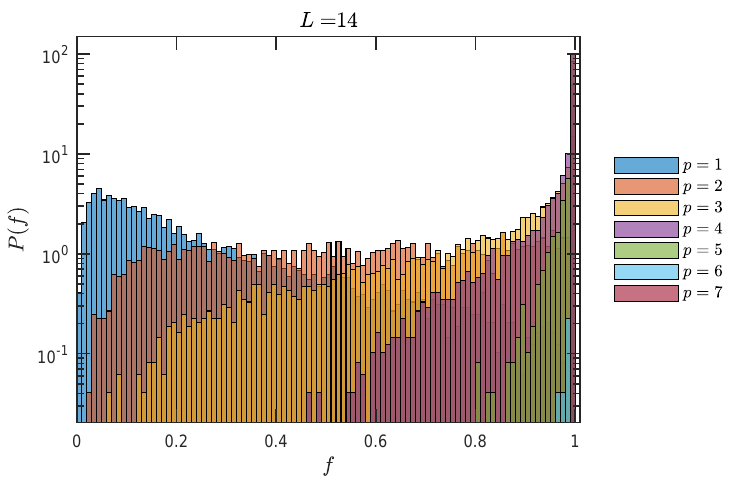
Figure 8: Probability distribution of optimal fidelities, for system size L = 14. For p = L / 2, the optimal fidelities are singularly peaked at f = 1, indicating that all in- stances of random states produced by VQCS perfectly; this is in contrast to p < L / 2 where there is some spread in the distribution, indicating that there are instances of random states for which VQCS get them. Probability distributions for other system sizes is qualitatively similar to one shown here.